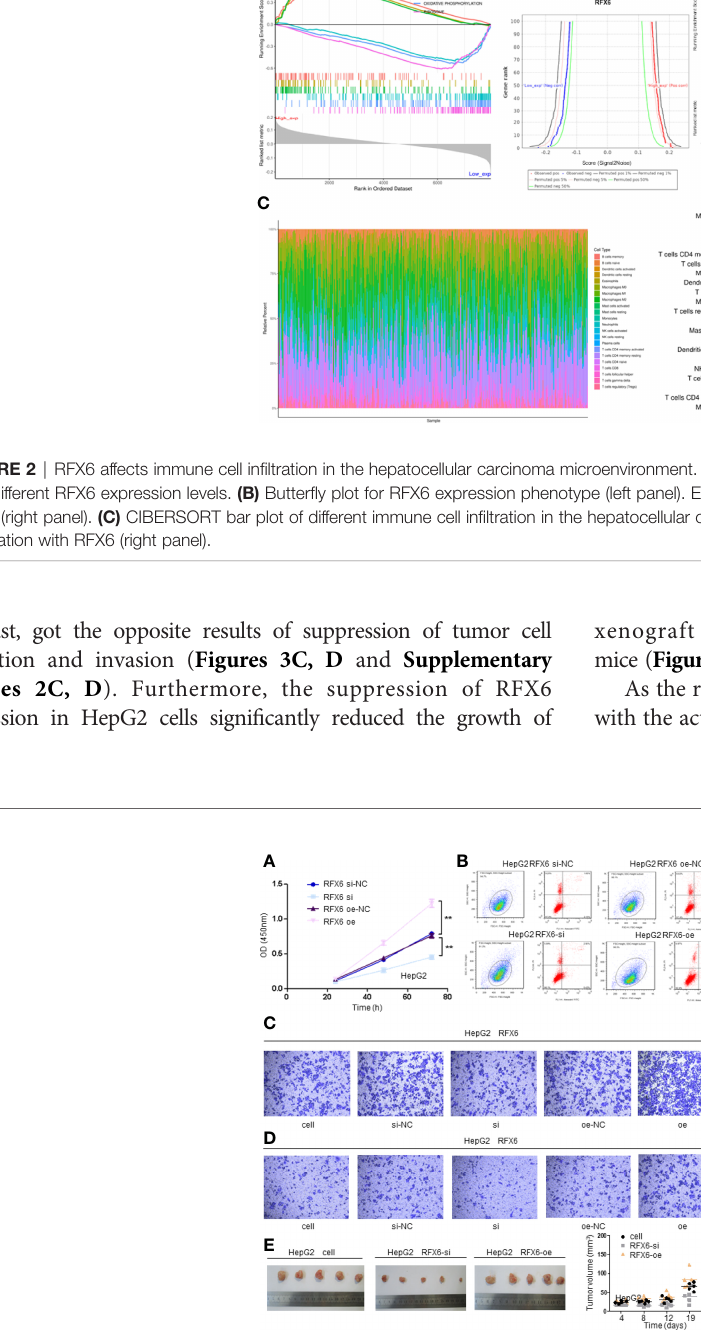
FIGURE 3 | Expression of RFX6 promotes the tumorigenesis of hepatocellular carcinoma. (A) The proliferation of HepG2 cells when altered by the expression of RFX6 in cells. The cell number was determined using the CCK-8 assay. Data were represented as mean ± standard deviation (SD), n = 3, ** p < 0.01. (B) The apoptosis of HepG2 before and after RFX6 alteration. Upper right (UR, PI + Annexin + ) and lower right (LR, PI − Annexin + ) were counted as apoptotic cells. Data were represented as mean ± standard deviation (SD), * p < 0.05, ** p < 0.01. (C) Expression of RFX6 promoted the migration of HepG2 cells using a Transwell assay. Data were represented as mean ± standard deviation (SD), n = 3, ** p < 0.01. (D) The knockdown of RFX6 could signi fi cantly inhibit the invasion of HepG2 cells. Data were represented as mean ± standard deviation (SD), n = 3, ** p < 0.01. (E) The knockdown of RFX6 suppressed the tumor growth of HepG2 cells in nude mice, n=5, *p < 0.05, **p <